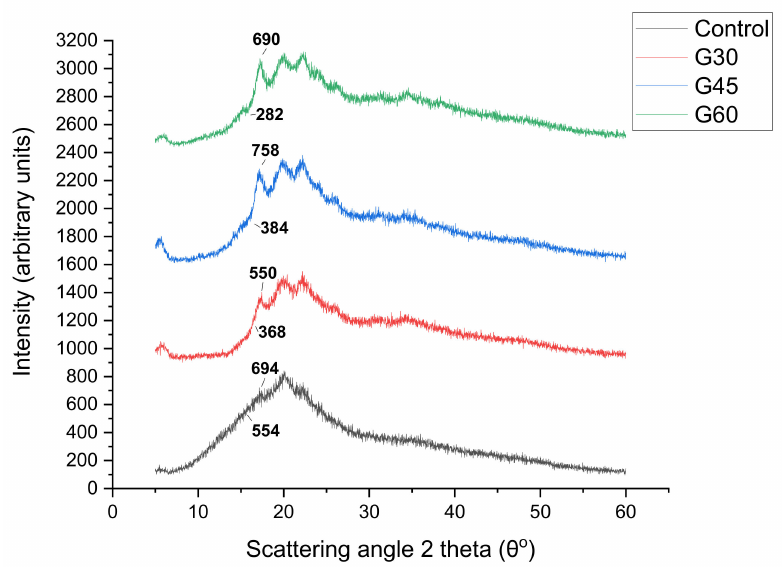
Figure 11. XRD of glycerol plasticized and unplasticized CS films.